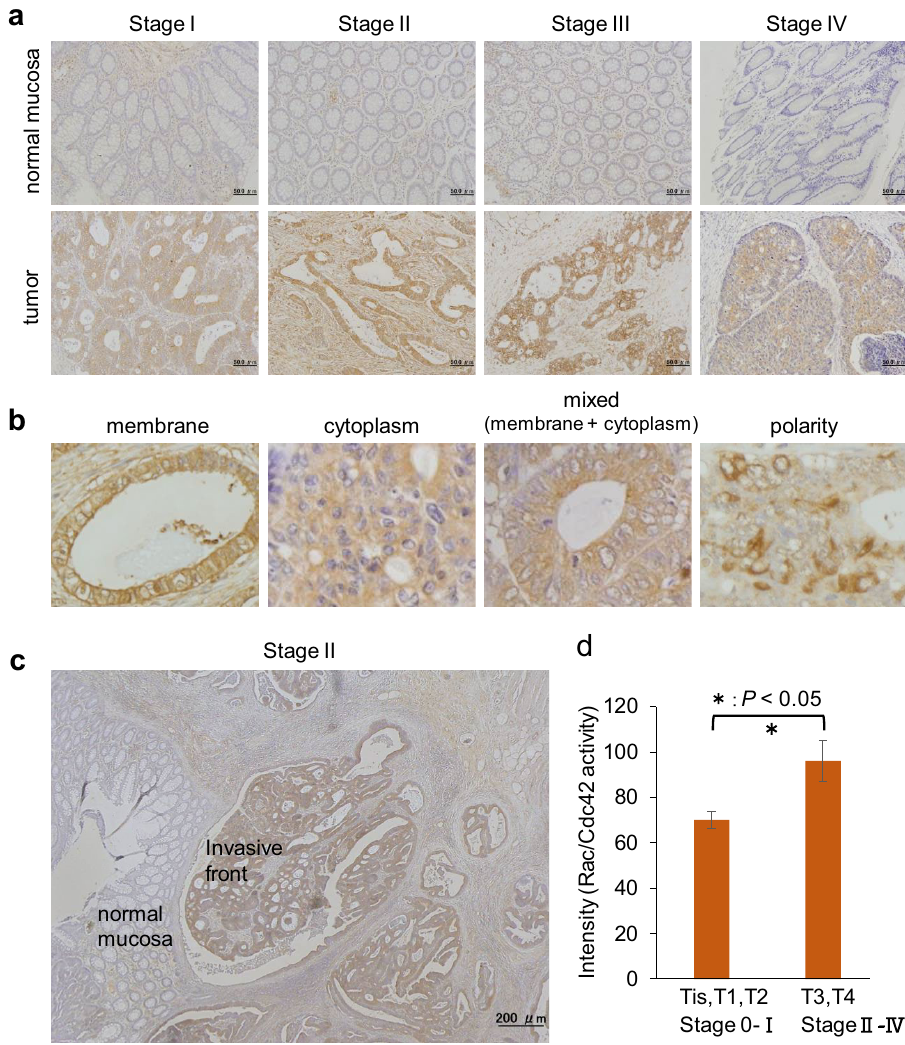
Figure 4. Rac1 activity in human colon cancer FFPE tissues correlates with tumor invasion. Immunostaining for active Rac and Cdc42 was performed in 50 human colon cancer FFPE tissues with the R-IHC system. ( a ) In identical patients, Rac/Cdc42 activity in normal mucosa (upper) and tumor area (lower) are displayed. ( b ) Micrographs and illustrations of representative activation patterns of Rac/Cdc42 are shown, designated as membrane, cytoplasm, mixed type of membrane and cytoplasm, and polarized distributions. Brown (DAB) and blue (hematoxylin) colors indicate Rac/Cdc42 activity and the nucleus, respectively. ( c ) Rac/Cdc42 activity in the invasive front of the tumor is shown. ( d ) DAB intensities showing Rac/Cdc42 activity were measured using Histoquest software, and the average values in two groups divided into Tis, T1, T2 and T3, T4 are shown with standard